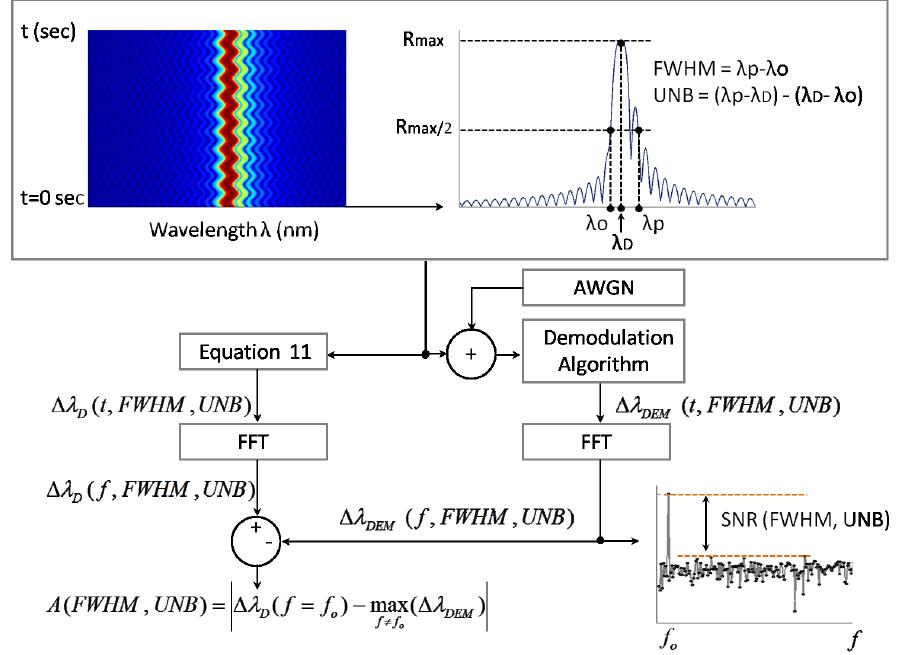
Methodology adopted to process the simulated spectra and to evaluate the performance of the demodulation